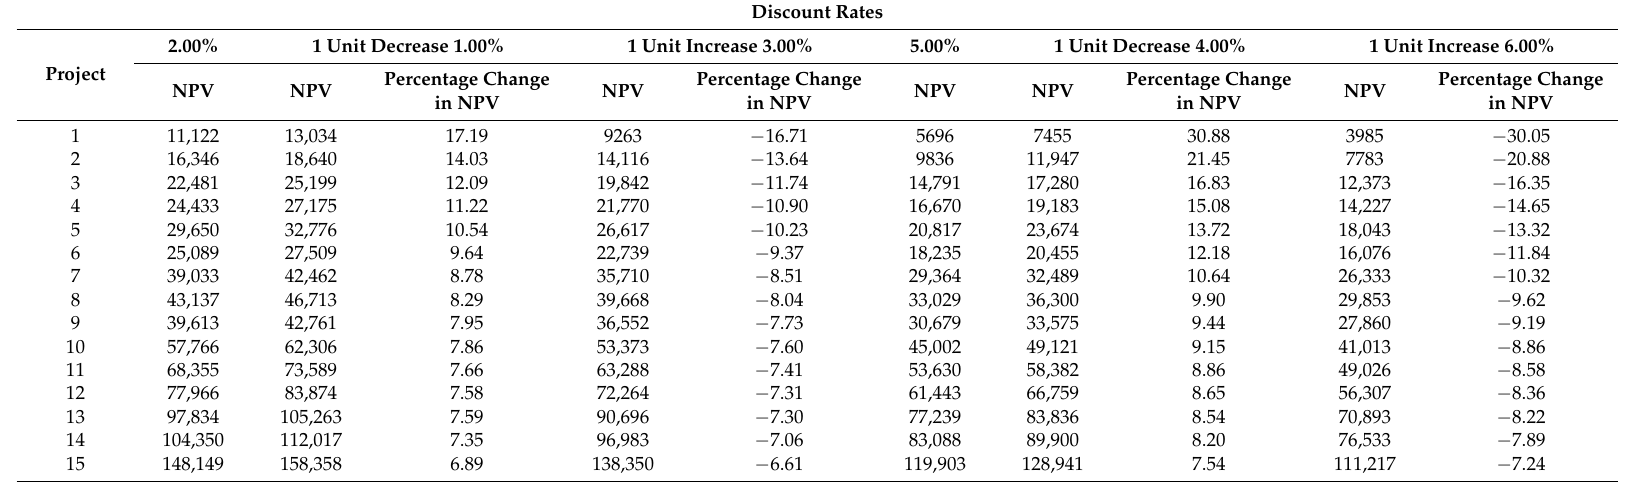
Table 1. The amount of change in NPV for one percent volatility in the discount